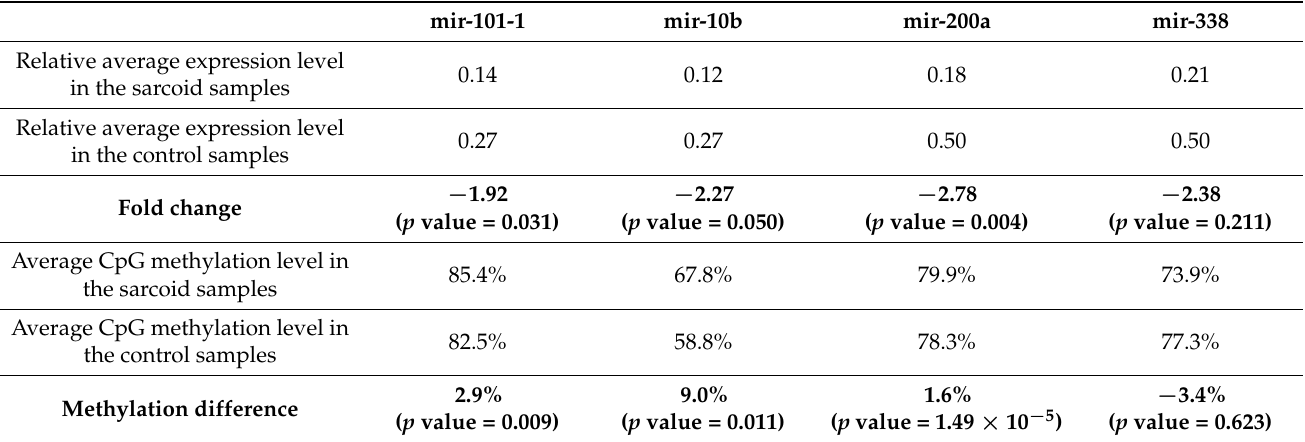
Table 3. Data on relative expression and DNA methylation levels of the investigated miRNA genes in the sarcoid tissue and control samples. Fold change expressed as −